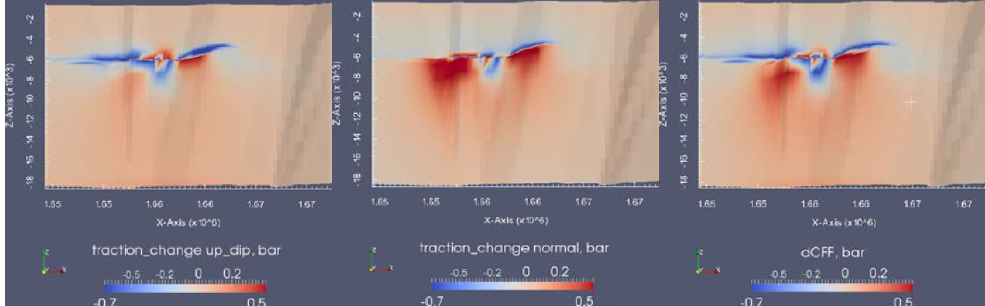
Figure 12. Mirandola fault and oilfield modeling without in situ stress reproduced from the Cavone report [7]: effective tractions and Coulomb stress function change dCFF on the fault on the 11,994 day for the case with bottom aquifer support. The change in the effective normal traction is positive near producers and negative near injectors because pressure depletion leads to contraction of the reservoir and pressure increase leads to increased compression on the fault. The white cross mark on the dCFF plot denotes the hypocentre